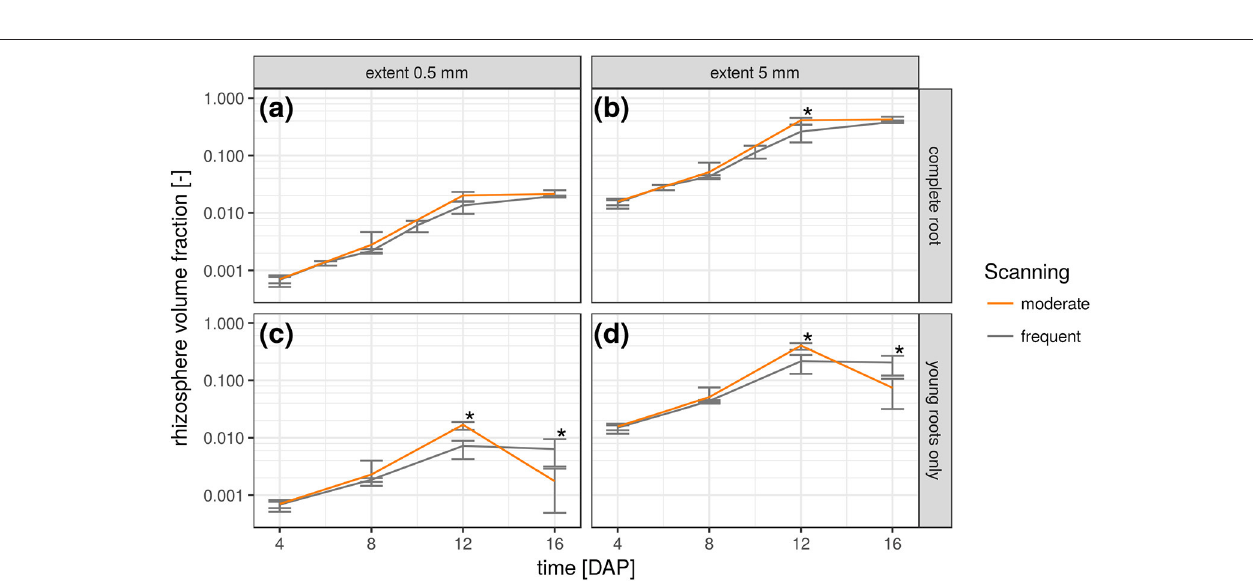
FIGURE 6 | Temporal change of rhizosphere volume fraction in both radiation treatments for two hypothetical rhizosphere radii (0.5 and 5mm) and shown separately for the complete root network (a,b) and only the young roots that have grown since the previous scan time (c,d) . Error bars refer to minimum and maximum for five biological replicates of each treatment and asterisk refers to significant differences tested at p <